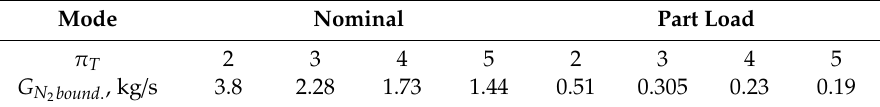
Table 4. Boundary values G N for a 6-cylinder 4-stroke diesel engine. 2 bound . Mode Nominal Part